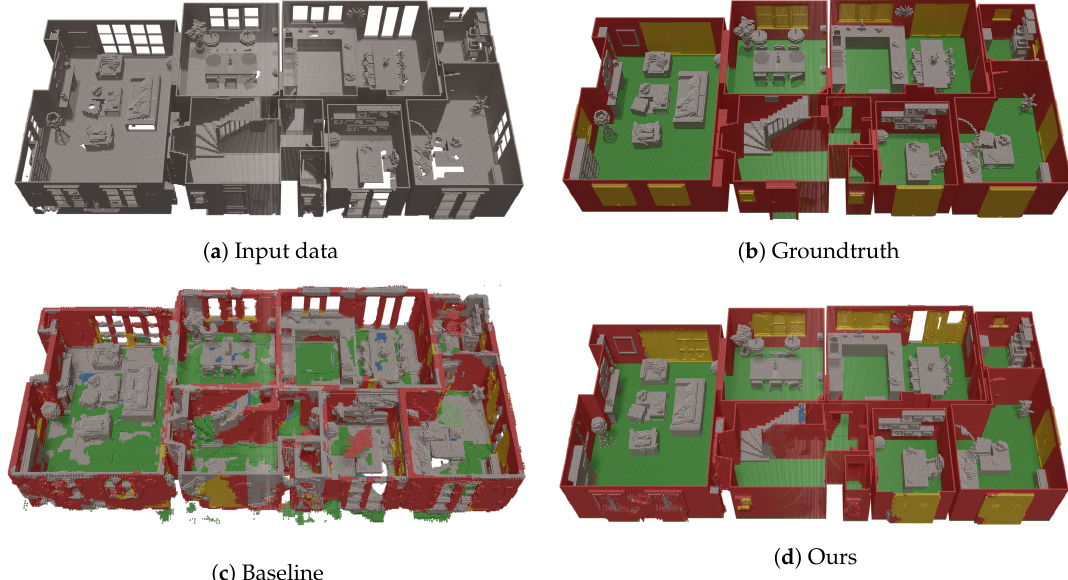
Figure 11. Qualitative evaluation of the baseline ScanComplete network compared to our implementation on a house from the test dataset (ground